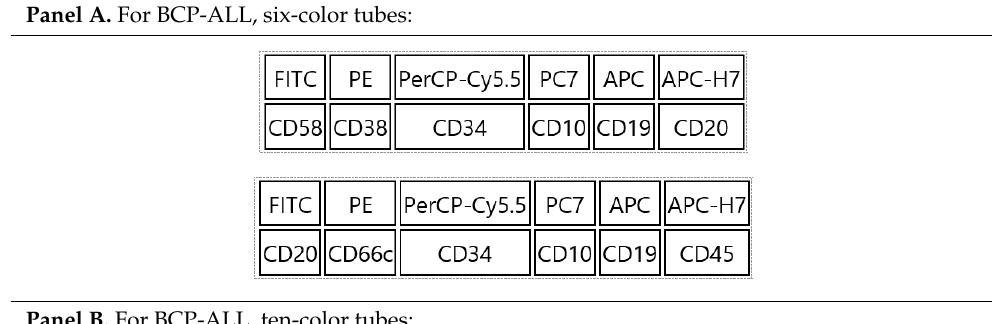
Table 1. A, B, C. Panels of monoclonal antibodies used for MRD monitoring. Panel A. For BCP-ALL, six-color tubes: